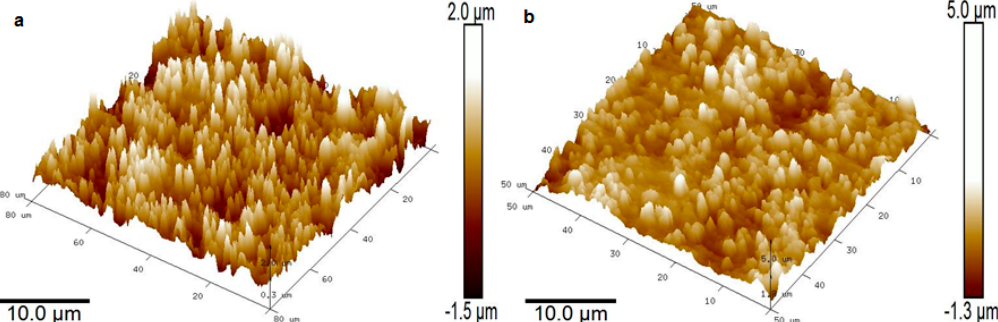
Figure 10. AFM 3D images of MS specimen: ( a ) without corrosion inhibitor and ( b ) with corrosion inhibitor.